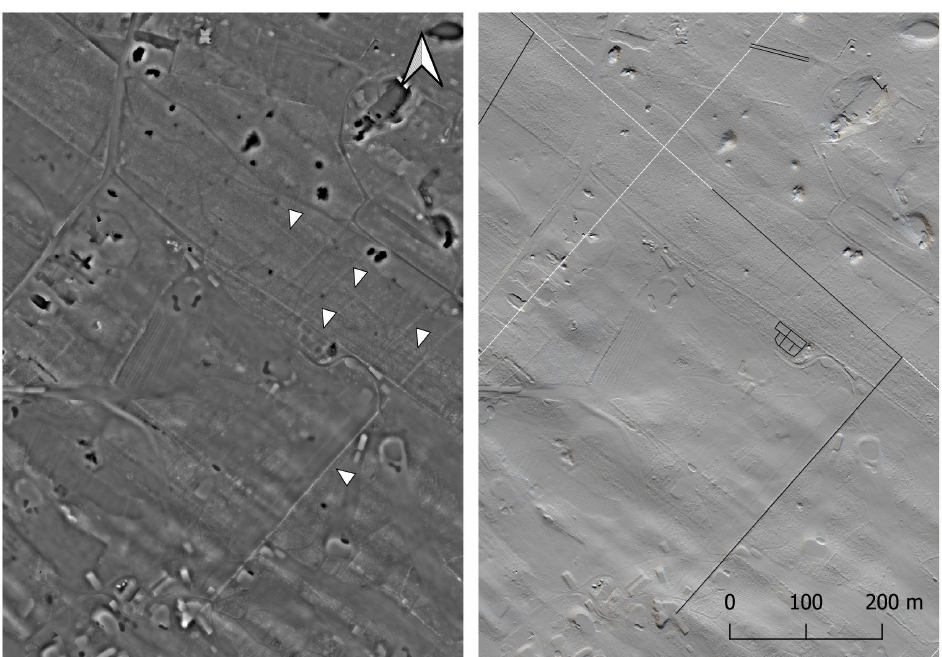
Figure 19. The rural complex of area L with the boundary walls indicated by white arrows in the local relief model ( left ) and black lines in the hill-shaded image ( right ). The north-eastern boundary wall perfectly fits the Roman centuriation grid of the Karst (dotted white lines) built fitting the main preserved limites in the Slovenian and Trieste Karst.